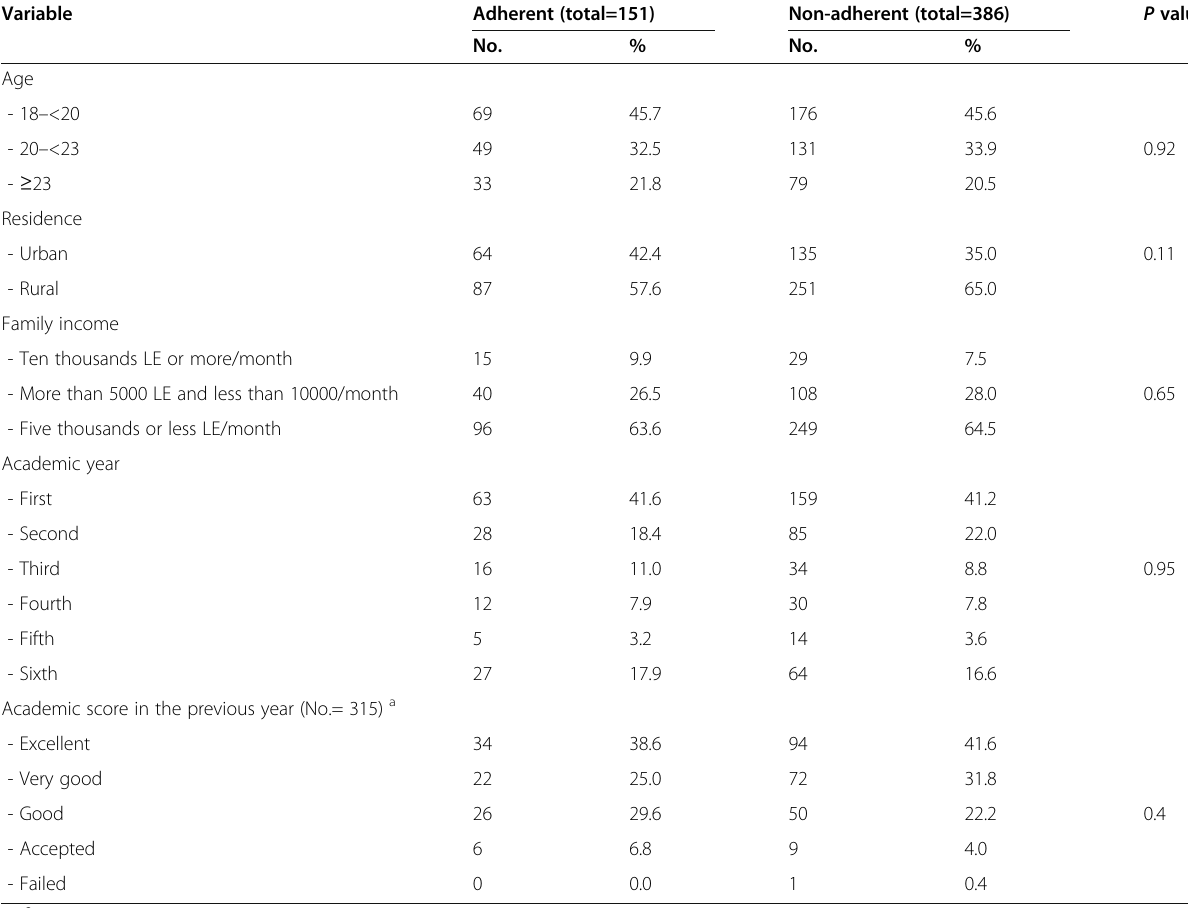
Table 4 Adherence status in relation to socio-demographic and academic characteristics of male students at Al-Azhar Faculty of Medicine, Cairo, Egypt, 2021